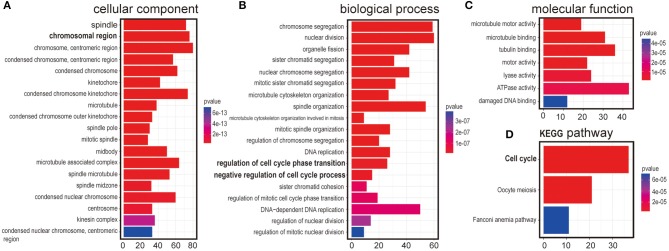
Annotation of LINC00993 via guilt-by-association correlation analysis. Gene Ontology (GO) analysis of LINC00993-related genes in cellular component (A), biological process (B), molecular function (C). (D) Kyoto Encyclopedia of Genes and Genomes (KEGG) pathway.